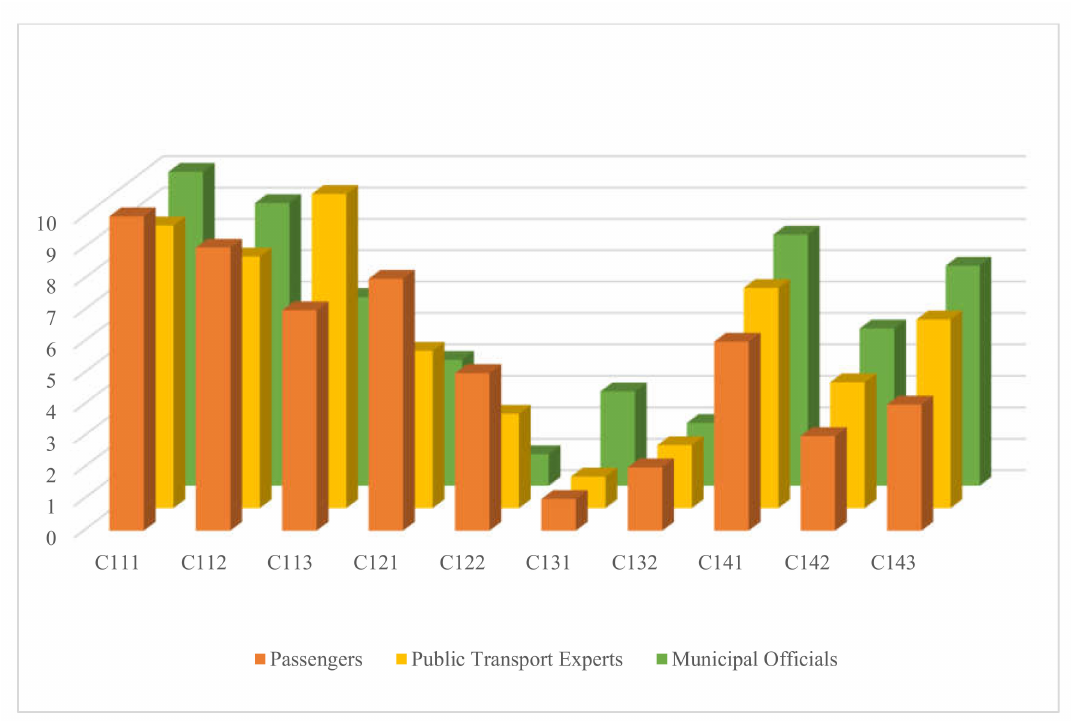
Figure 5. The subfactors ranks based on the di ff erent group preferences on the third